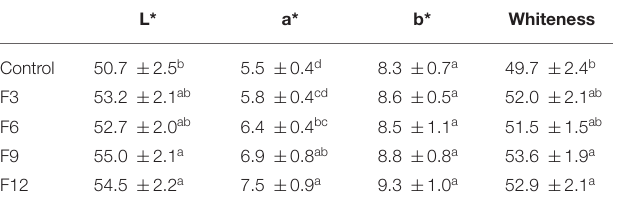
TABLE 4 | Instrumental color of prebiotic burgers.